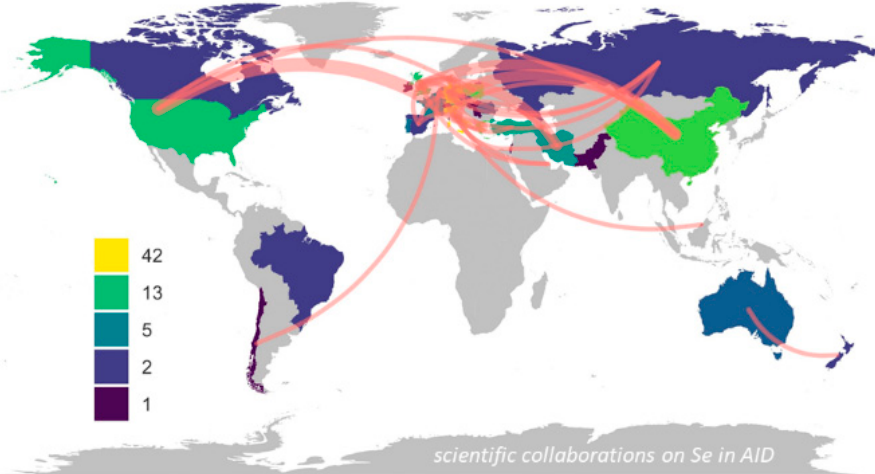
Figure 2. Overview on international collaborations on a potential role of Se in autoimmune disease. Countries with prevalent Se deficiency are particularly active in this line of research. The red lines indicate collaborations as published in the Web of Science (accessed on 4 April, 2021), with line thickness corresponding to the number of entries. The countries are color-coded for the number of contributions, with Denmark, Germany, and Italy yielding highest marks (yellow). Analysis was conducted for references matching the term “ALL = (selenium autoimmune thyroid)”, using the ‘bibliometrix’ and ‘ggplot2’ packages in R (Version 2.1.0, R: A Language and Environment for Statistical Computing; The R Foundation for Statistical Computing: Vienna, Austria, 2020).